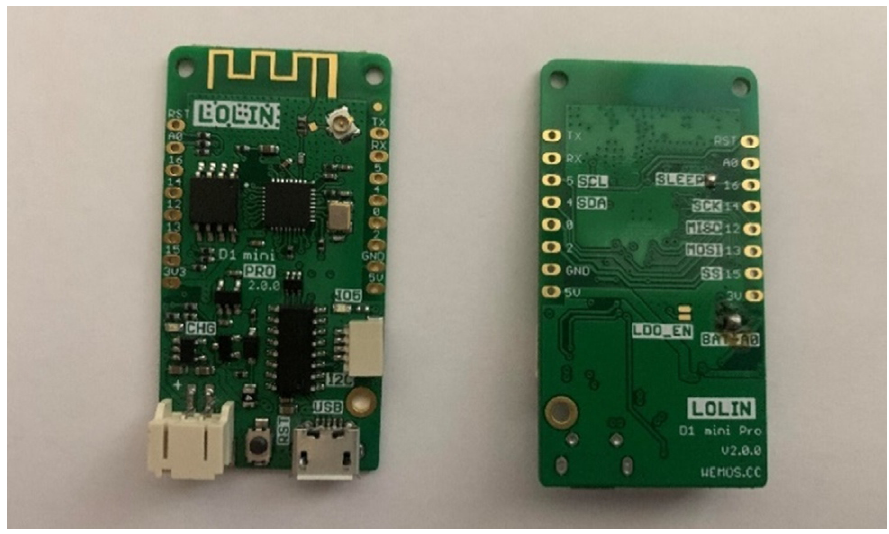
Figure 2. ESP8266 device.